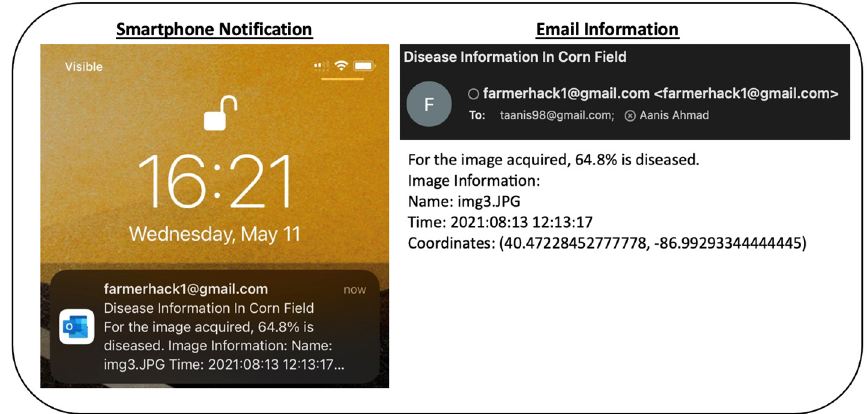
Figure 14. Email notification corresponding to diseased corn fields sent to users from the GeoDLS.